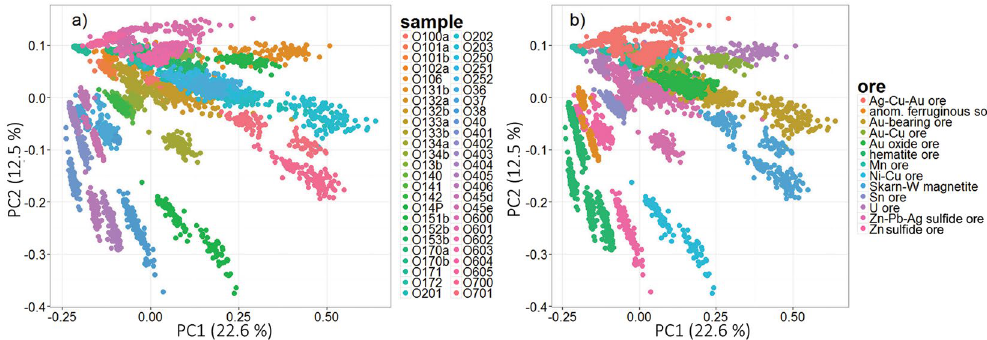
Figure 6. PCA scores of 225 selected points from echellograms, where data were classified according to ( a ) individual sample and ( b ) specific